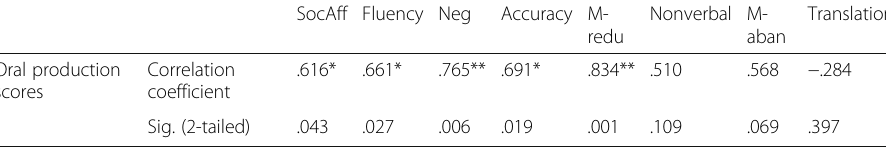
SocAff Fluency Neg Accuracy M-